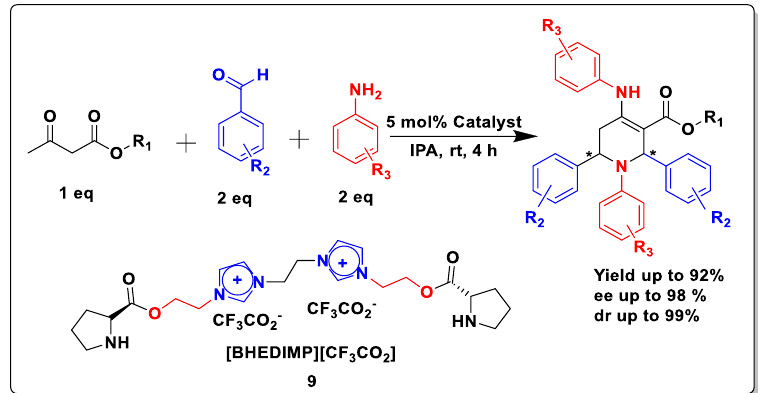
Table 2. Optimization of catalyst for THP derivatives a .